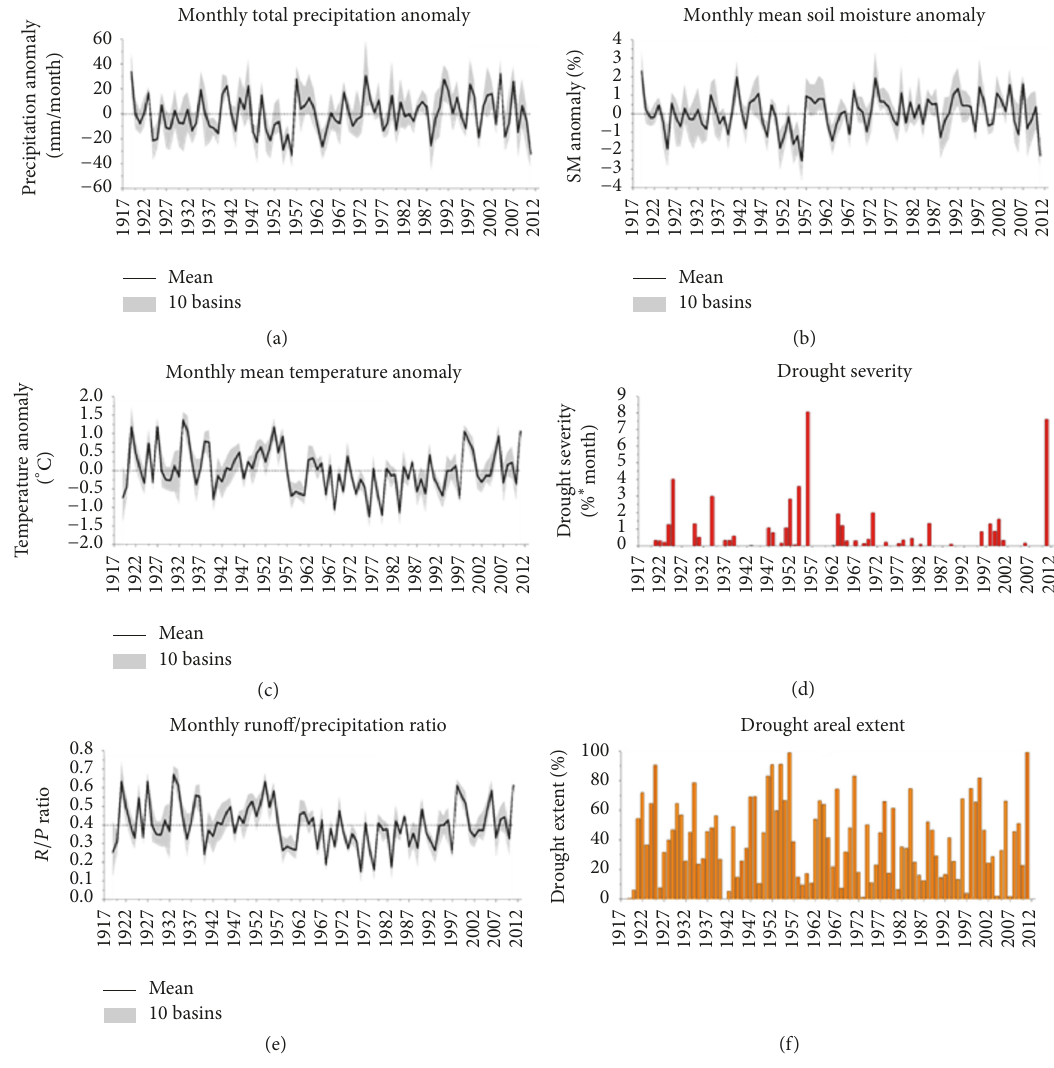
Figure 5: 20th-century Texas drought outlook (climate, surface hydrology, drought severity, and drought areal extent).